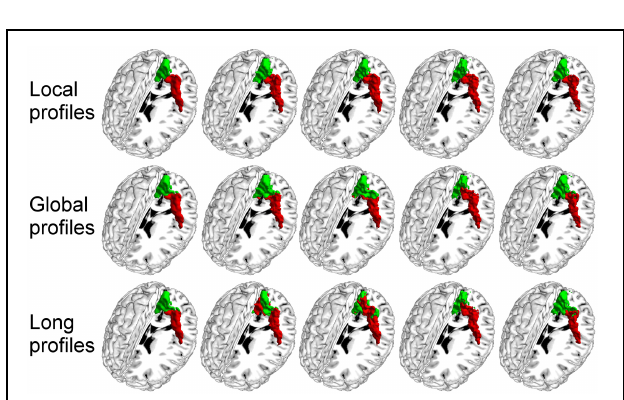
FIGURE 3 | The MPM results for the primary cerebral cortices based on resting-state fMRI.